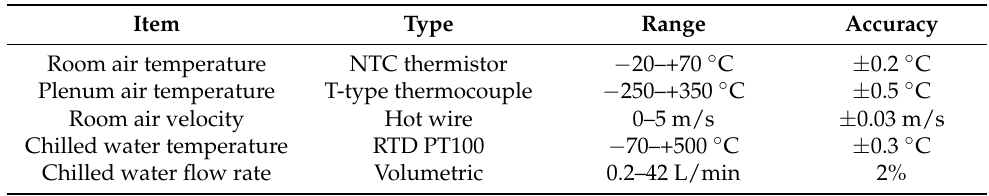
Table 1. Specifications of measurement device.